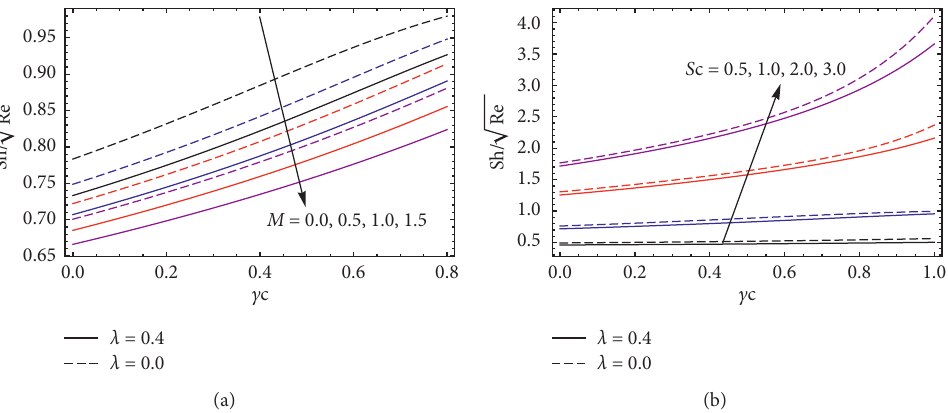
Figure 8: Impact of the Sherwood number on combined parameters. (a) c